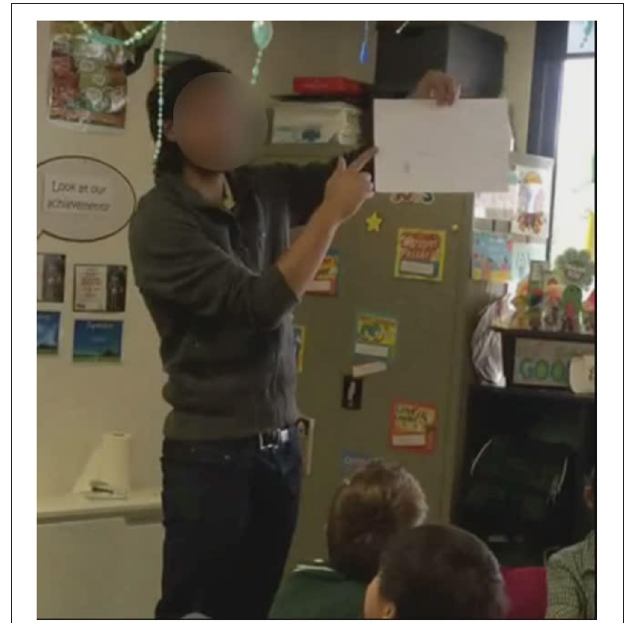
FIGURE 7 | Holding up Noel’s drawing as an exemplar of representation of the sun’s movement.